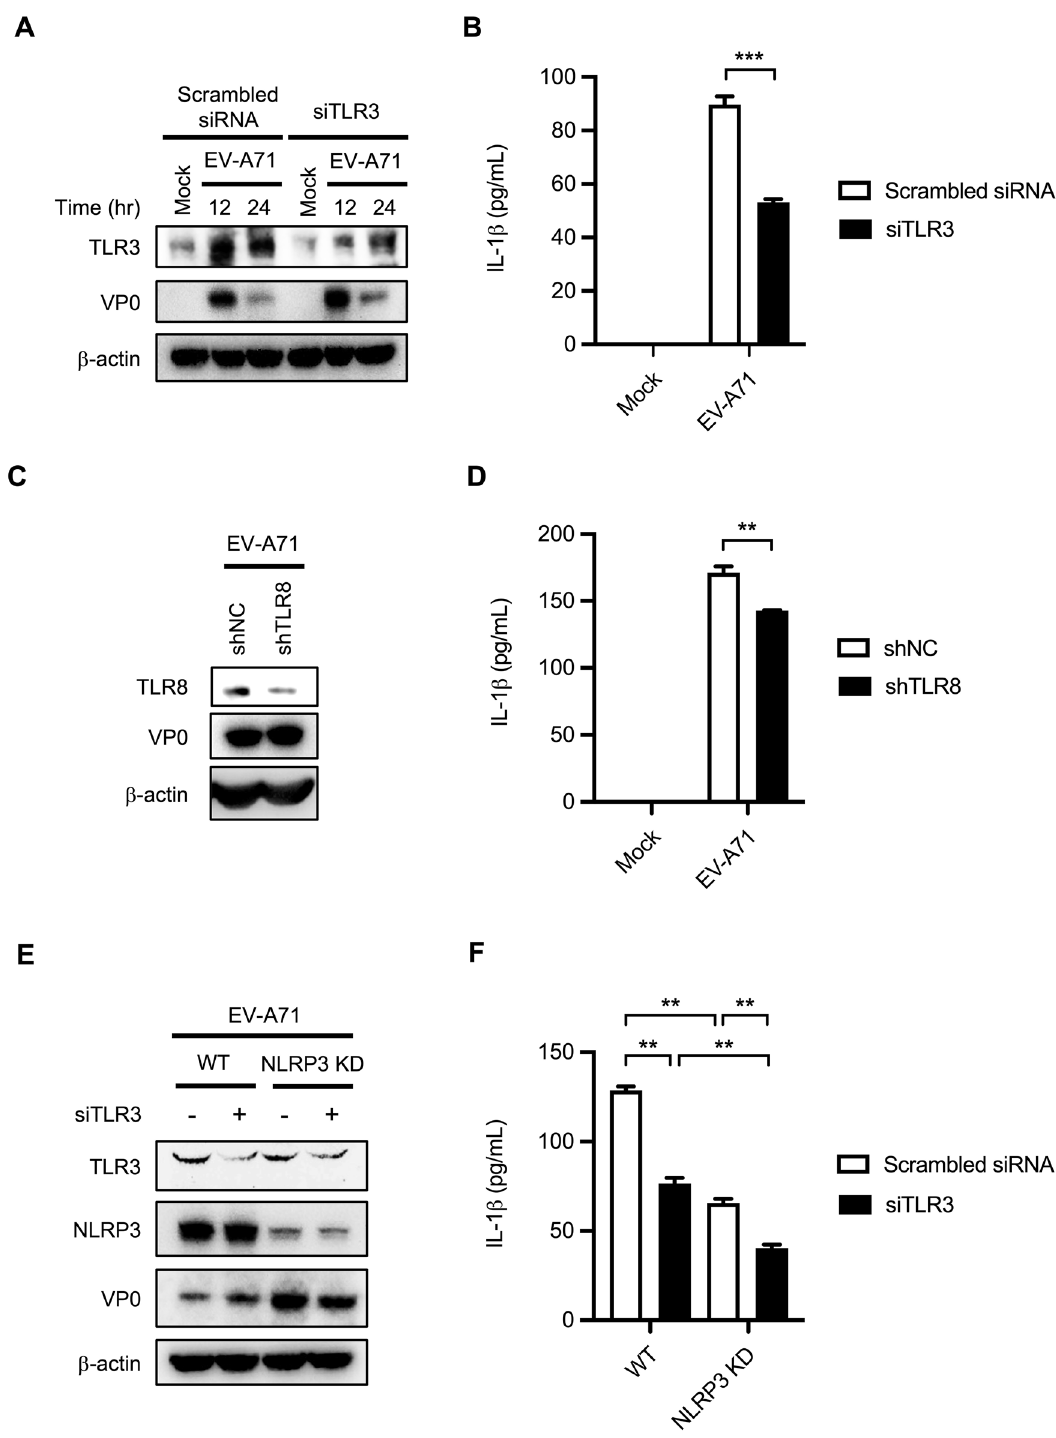
Figure 5. TLR3 and TLR8 are involved with EV-A71-induced IL-1β production in THP-1 macrophages. ( A ) Specific TLR3 siRNA or scrambled siRNA was transfected into PMA-primed THP-1 cells for 48 h. Cells were then infected with EV-A71 at the M.O.I. of 2 for 12 h. The expression of TLR3, EV-A71 viral protein VP0, and β-actin was analyzed by Western blot. ( B ) The IL-1β levels in the supernatants were determined by ELISA. ( C ) THP-1 cells were transduced with shNC or shTLR8. The transfected cells were selected and maintained in the puromycin-containing medium. The selected cells were infected with EV-A71 at the M.O.I. of 2 for 12 h. The expression levels of TLR8 and EV-A71 VP0 were examined by Western blot analysis. ( D ) The IL-1β levels in supernatants were assessed by ELISA. ( E ) Wildtype (WT) and NLRP3 KD THP-1 macrophages were transfected with siTLR3 or scrambled siRNA. The transfected cells were infected with EV-A71 at the M.O.I. of 2 for 12 h. The expression levels of TLR3, NLRP3, EV-A71 VP0, and β-actin were determined by Western blot analysis. ( F ) The supernatant was collected and the secreted IL-1β was analyzed by ELISA. Data are expressed as mean value ± SD (** p < 0.01, *** p < 0.001, Student’s unpaired